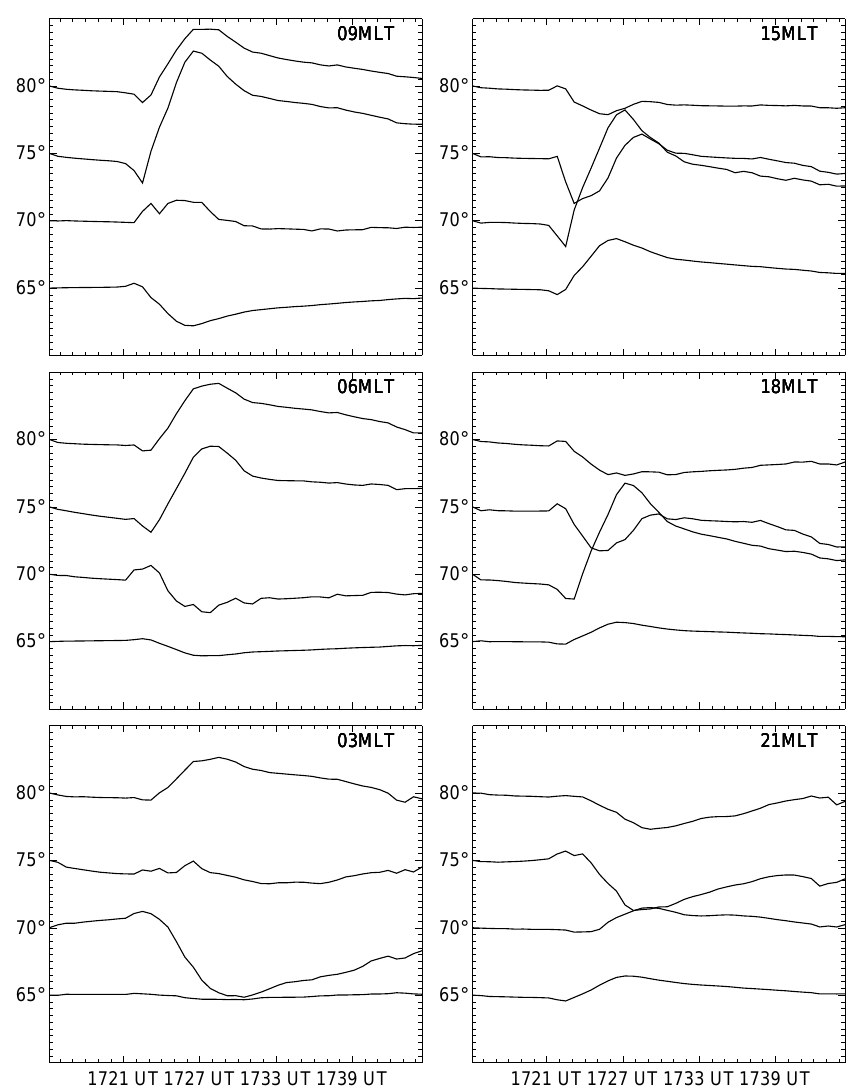
Fig. 4. The H component of the ground magnetic perturbations in the Northern Hemisphere at 6 different longitudes (6 panels) at various latitudes (4 lines in each panel). The interval of perturbations between latitudes is